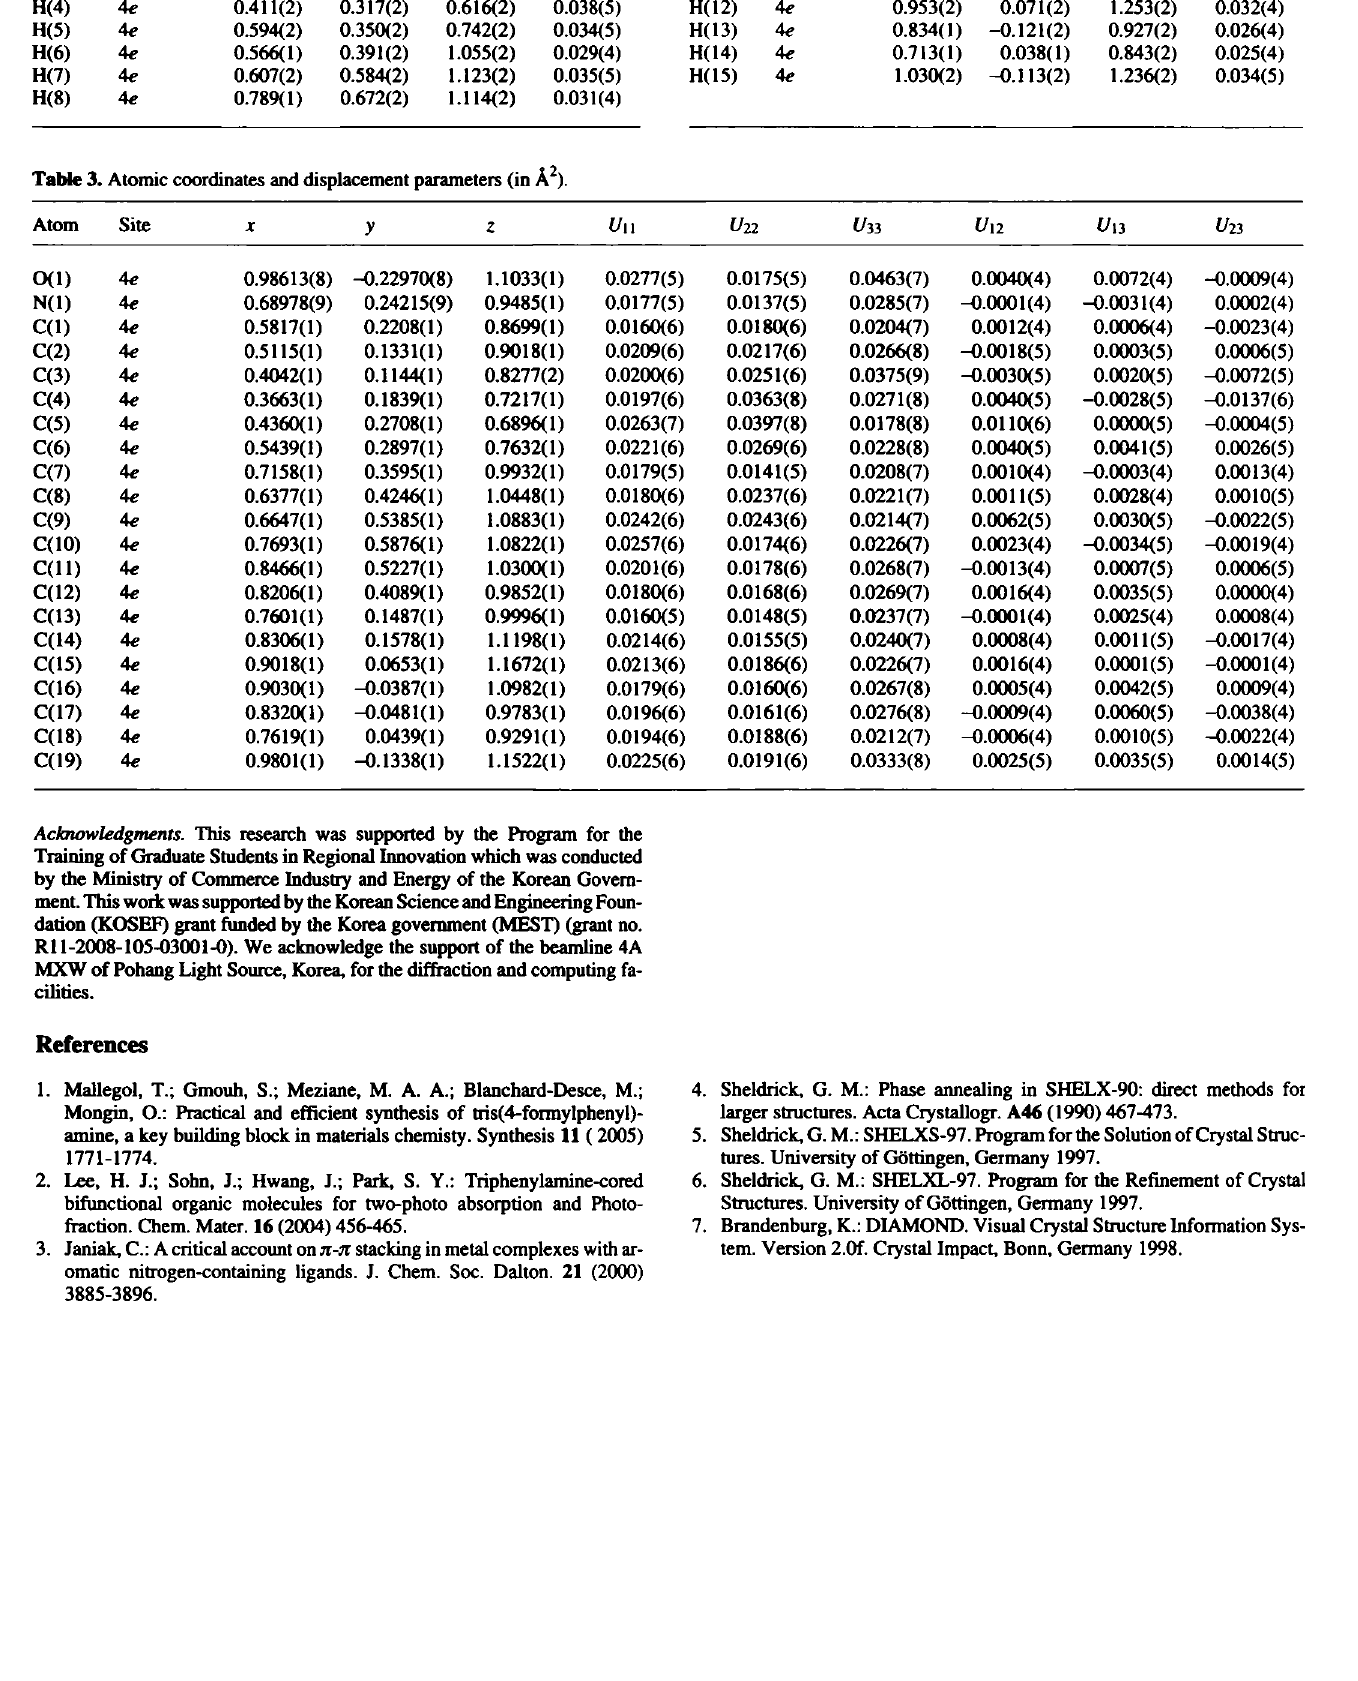
Table 3. Atomic coordinates and displacement parameters (in Â 2